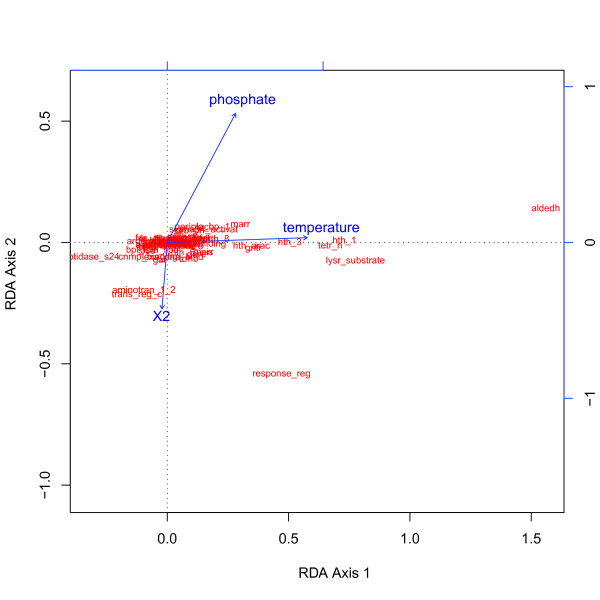
RDA biplot of TFs constrained by environment stability and space. The ordination of TFs (in red) constrained by the explanatory variables (blue vectors) is shown. The lengths of the vectors correspond to the strength of the effect of that particular variable. RDA scaling 2 was used (scaling the TF scores). The angle between an explanatory variable vector and a TF (if a vector was to be drawn from the origin of the graph to this TF) approximates their correlation.